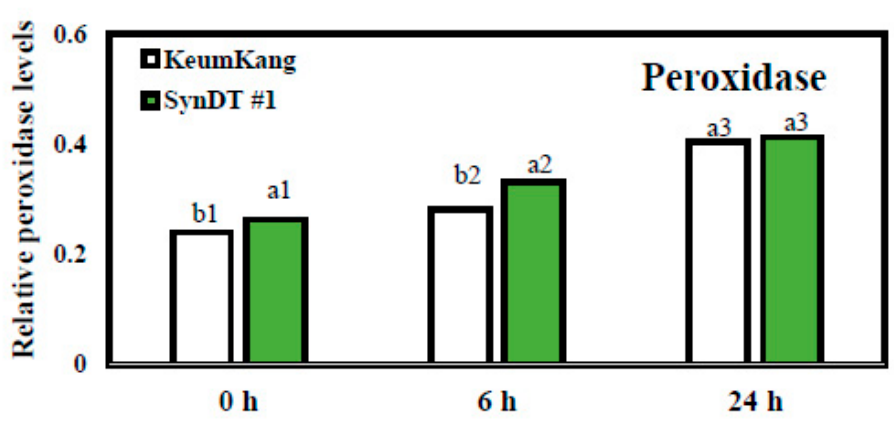
Figure 8. Levels of peroxidase in Keumkang and SynDT #1 in response to leaf rust (LR) at 0, 6, and 24 hpi . Eight-day-old seedlings were exposed to LR. Samples were collected after 0, 6, and 24 hpi for enzymatic assay. The experiments were conducted at least twice to verify that the results were consistent. Standard deviation value was calculated from three replicates in each treatment. One-way ANOVA and Tukey’s test ( α = 0.05) were performed using SAS. Different letters (a, b, or c) indicate significant differences ( p < 0.05).